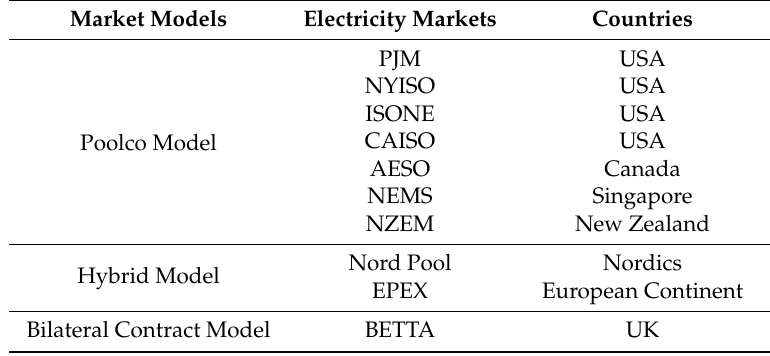
Figure 1. Difference between poolco model, hybrid model, and bilateral contract model. Table 1. Market models of different electricity markets